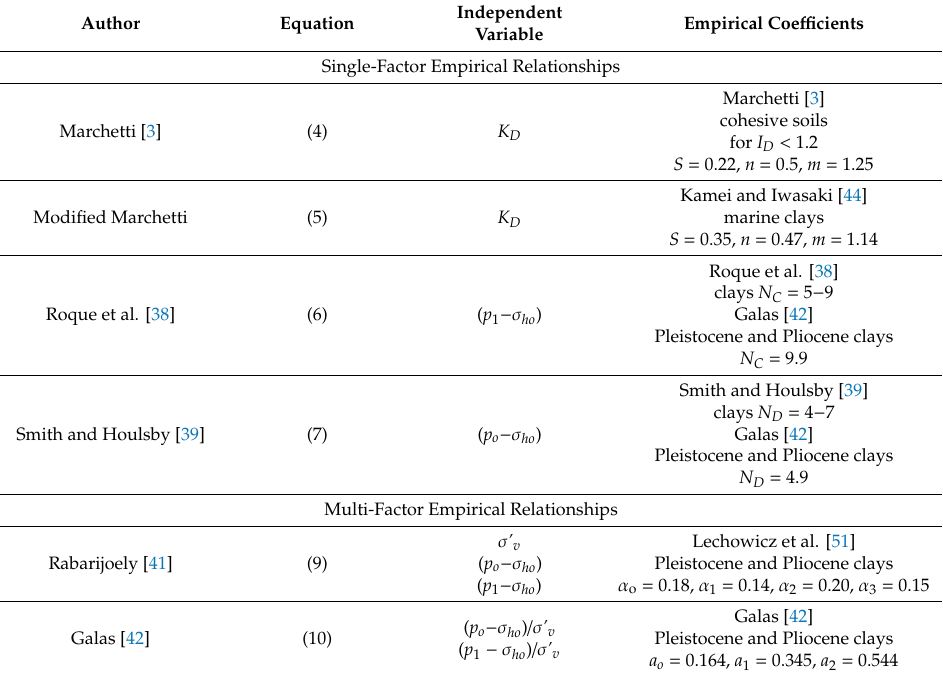
Table 1. Empirical coe ffi cients in single- and multi-factor relationships to evaluate undrained shear strength τ fu from the dilatometer